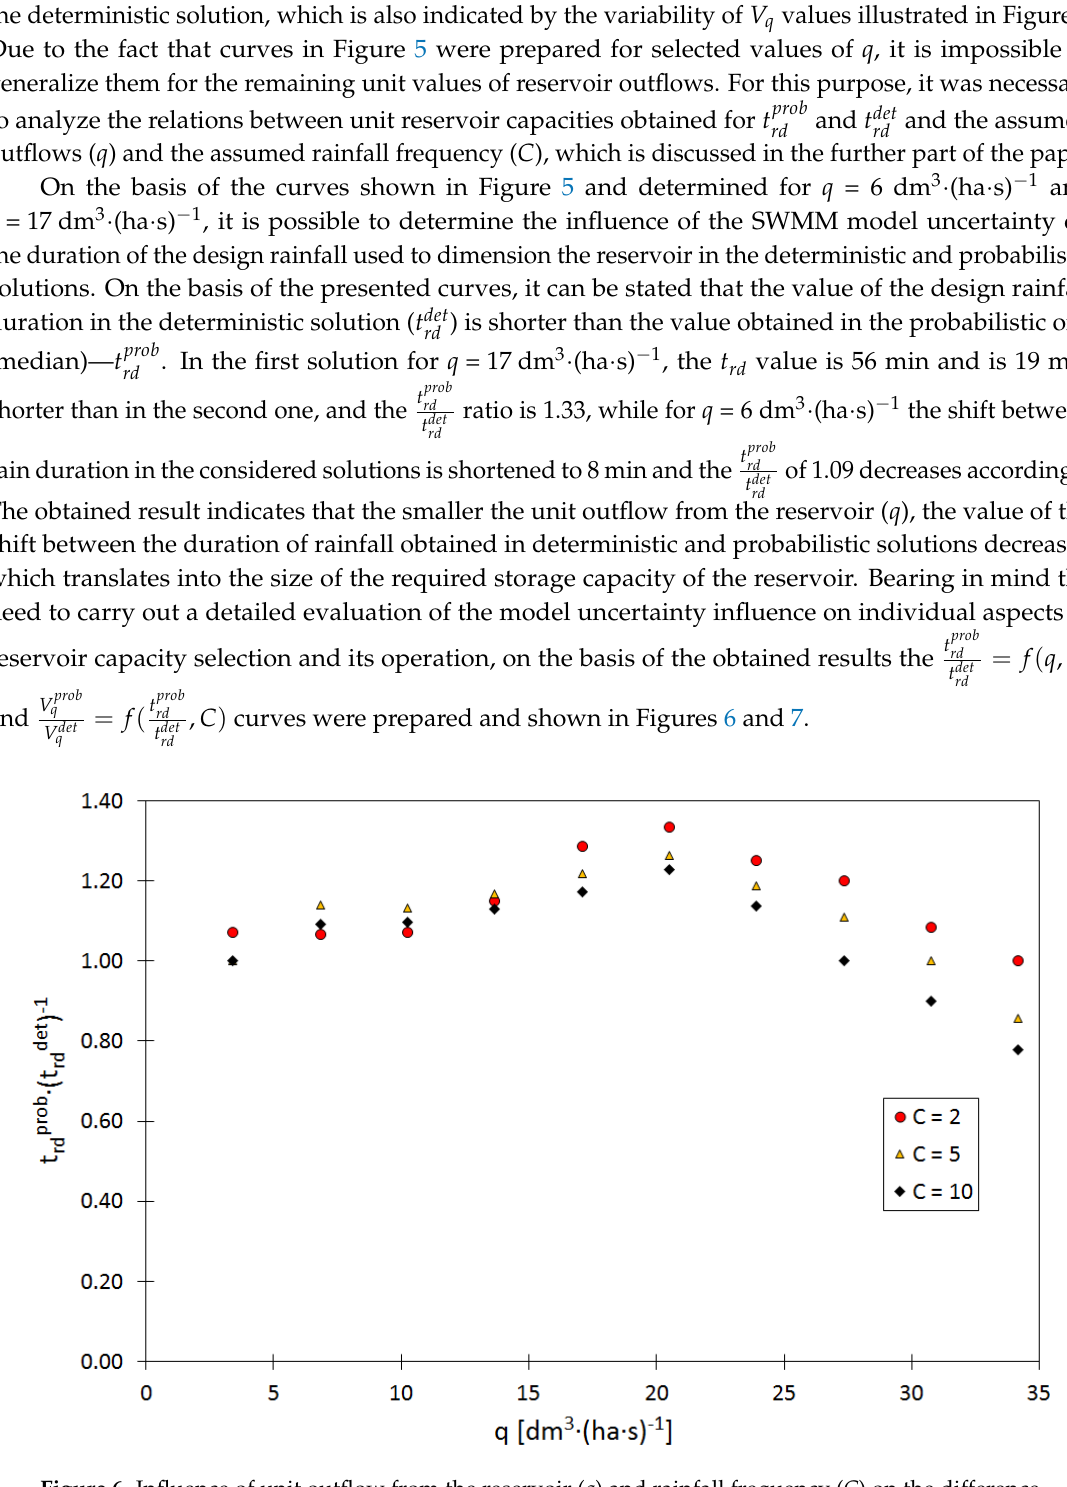
Figure 6. Influence of unit outflow from the reservoir ( q ) and rainfall frequency ( C ) on the difference between the design rainfall duration obtained for deterministic and probabilistic solutions.